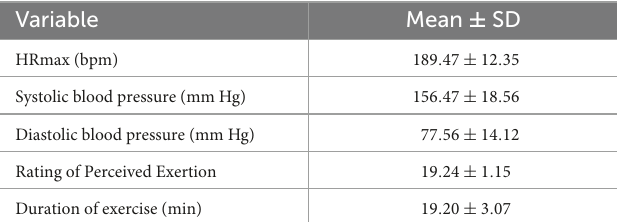
TABLE 3 Behavior and physiological parameters of participants at the end of